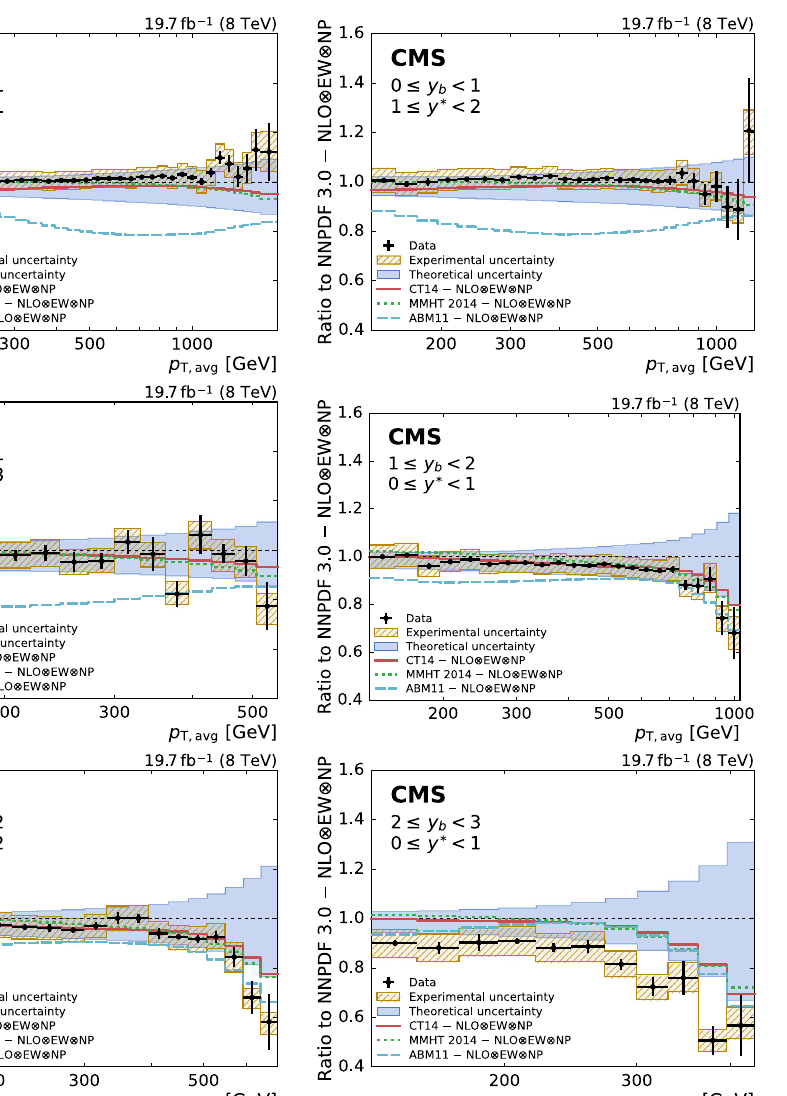
shows the PDF, scale, and NP uncertainties quadratically added; the solid and dashed lines give the ratios calculated with the predictions for different PDF